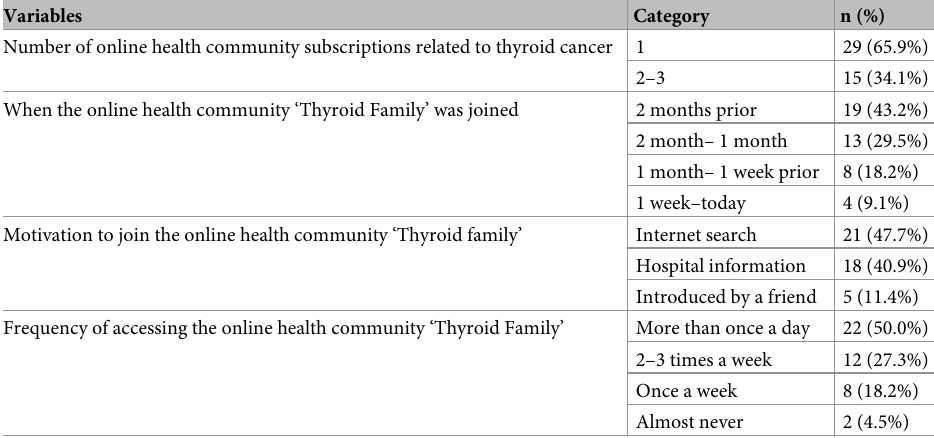
Table 2. Characteristics of patients using an online health community (n = 44).